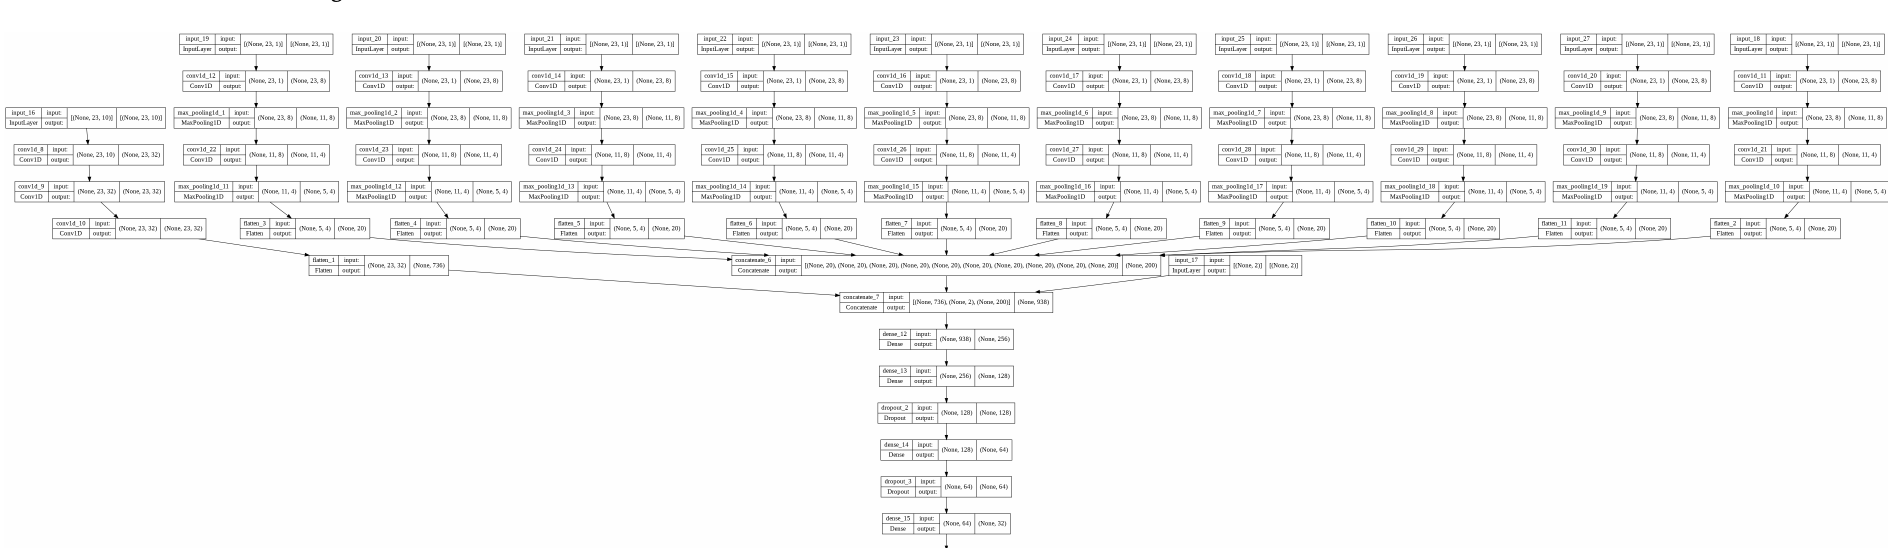
Figure A6. Univariate + multivariate.